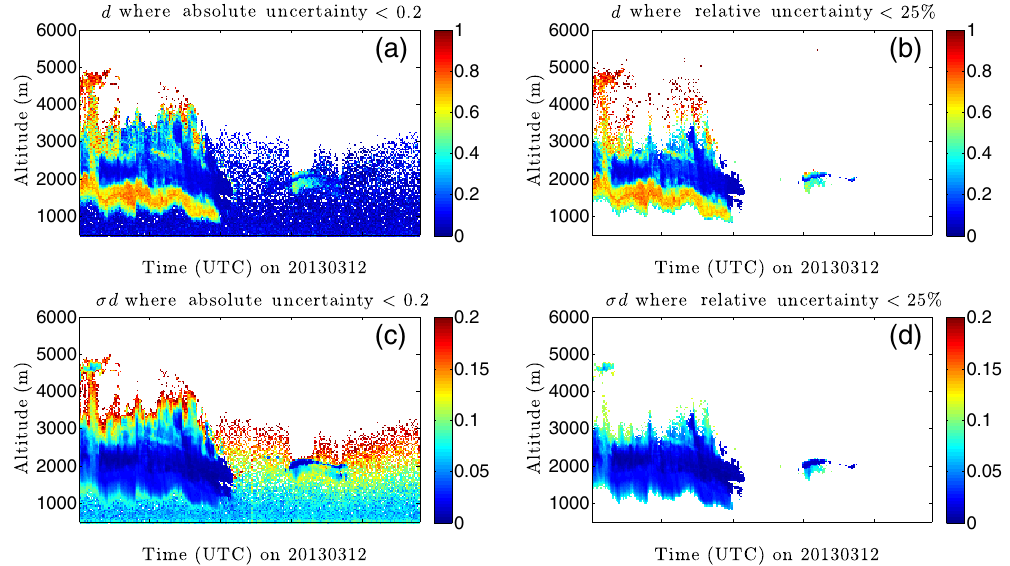
Figure 6. Atmospheric depolarization parameter measurements from 12 March 2013, with associated absolute uncertainties in units of depolarization parameter. In the left panels of d (a) and σd (c) , all data points with absolute uncertainty greater than 0.2 have been eliminated. In the right panels of d (b) and σd (d) , points with relative uncertainty greater than 25% have been eliminated instead. Resolution is 5min ×